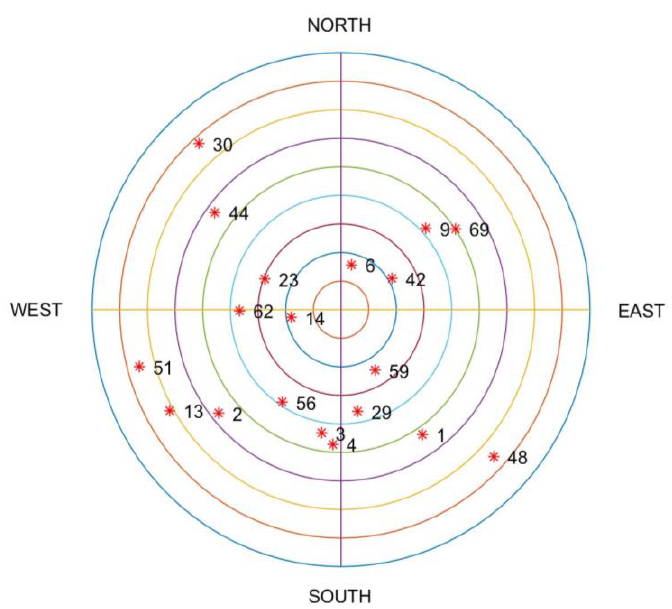
Figure 8. The status of satellites at the beginning of simulation.